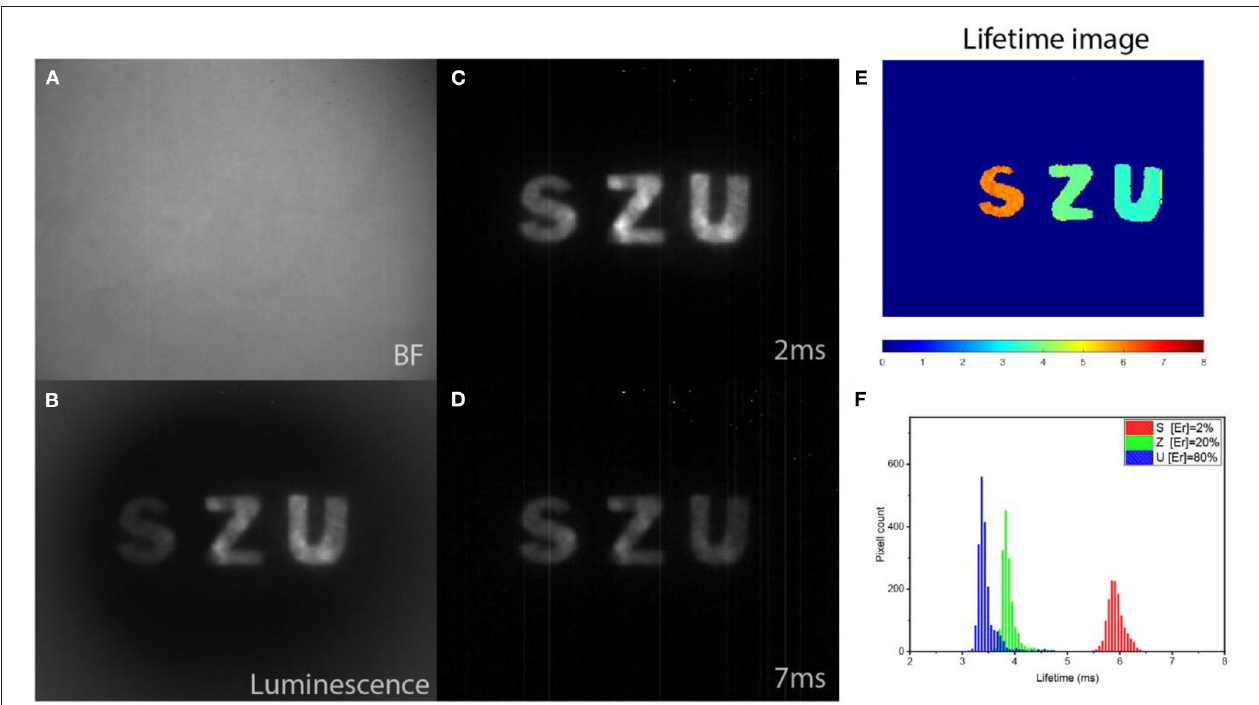
FIGURE 4 | (A) Bright-field image of paper with invisible patterns acquired by SWIR camera at room illumination. (B) Steady-state PL intensity imaging revealing a SWIR PL pattern hidden under paper layer and excited by continuous wave laser irradiation at 975nm. (C,D) Time-gated SWIR PL images acquired with 2- and 7-ms delays after pulsed excitation at 975nm, respectively. (E) SWIR PL lifetime image generated with using RLD algorithm using images shown as (C,D) . (F) Lifetime image histogram illustrating pattern of three separate lifetime-encoded